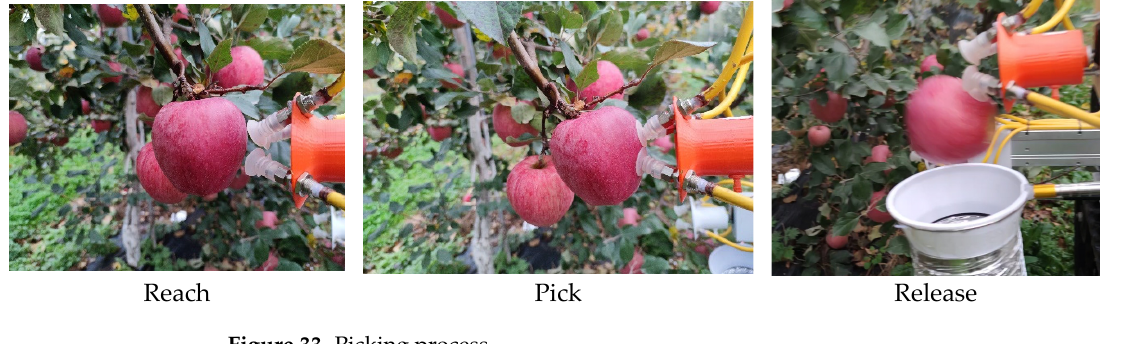
Figure 33. Picking process.